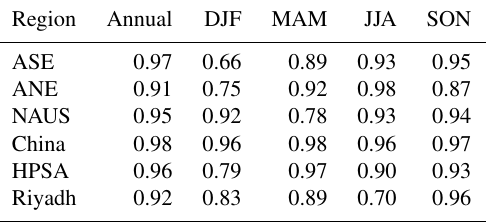
Table 6. Correlation between UV NO 2 VCDs and vis blue NO 2 VCDs for the six selected